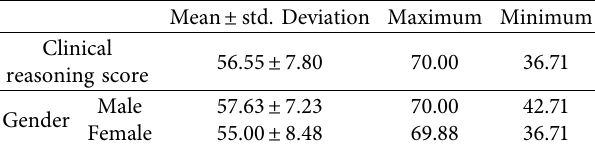
Table 5: Clinical reasoning scores of students from the KF test.